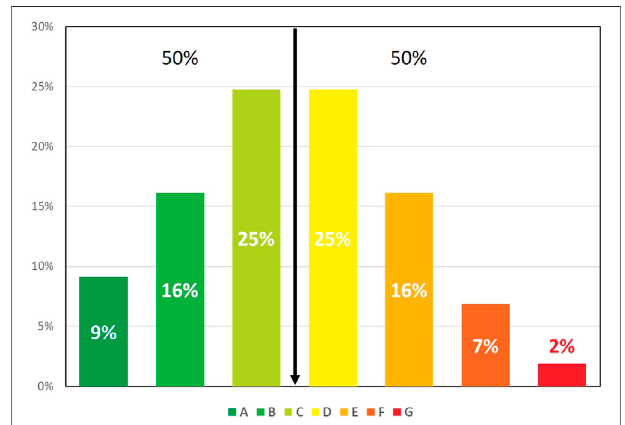
FIGURE 2 | Suggested ECO Class classi fi cation ranges; Eco Classes generated on market analysis clustered in contribution of respective SPF reference group and related EI cs classi fi cation ranges.